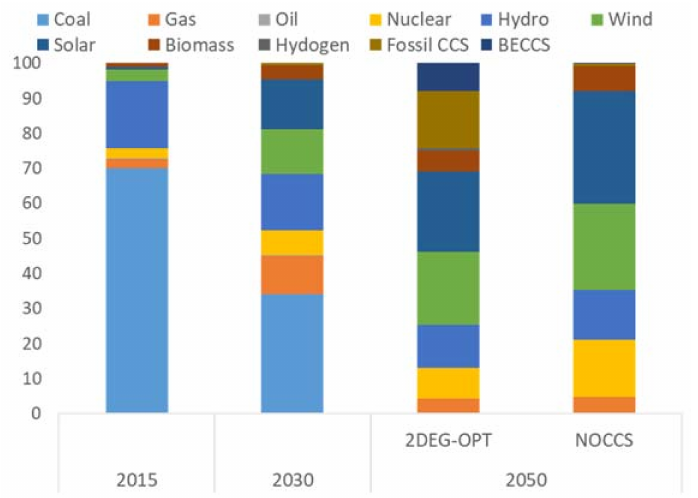
Figure 8. China’s power generation mix by technology in alternative scenarios over